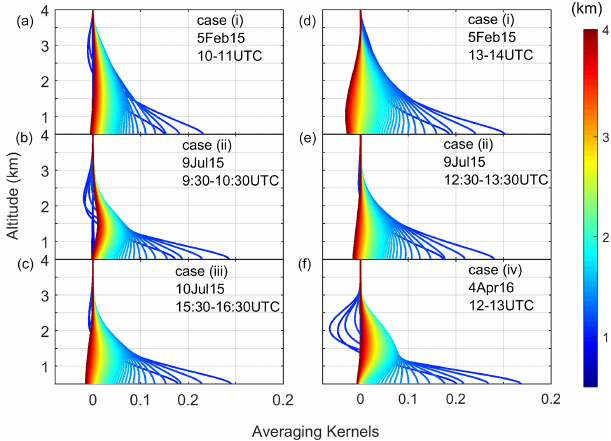
Figure 5. Averaging kernels of the aerosol retrievals for the four case studies. For cases (i) and (ii), the left and right panels cor- respond to the morning and afternoon profiles, respectively. The colour bar represents the height of the atmospheric